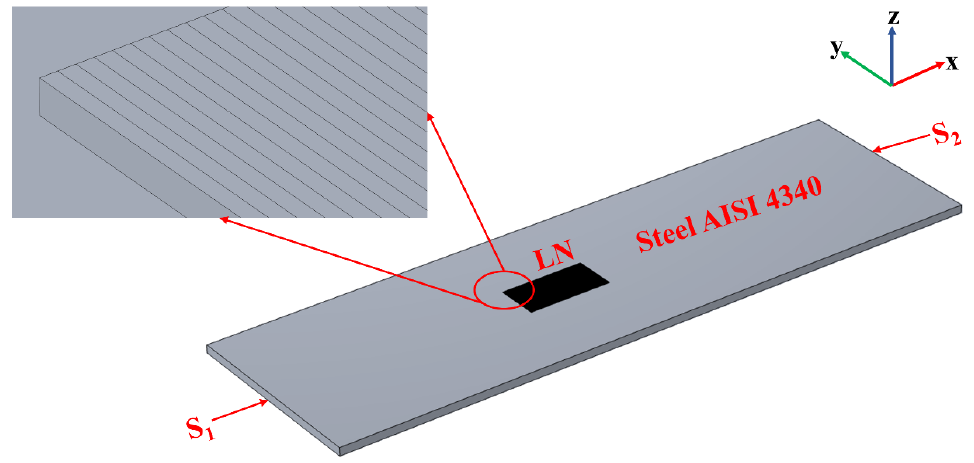
Figure 3. A 3D simulation model for strain transfer analysis.